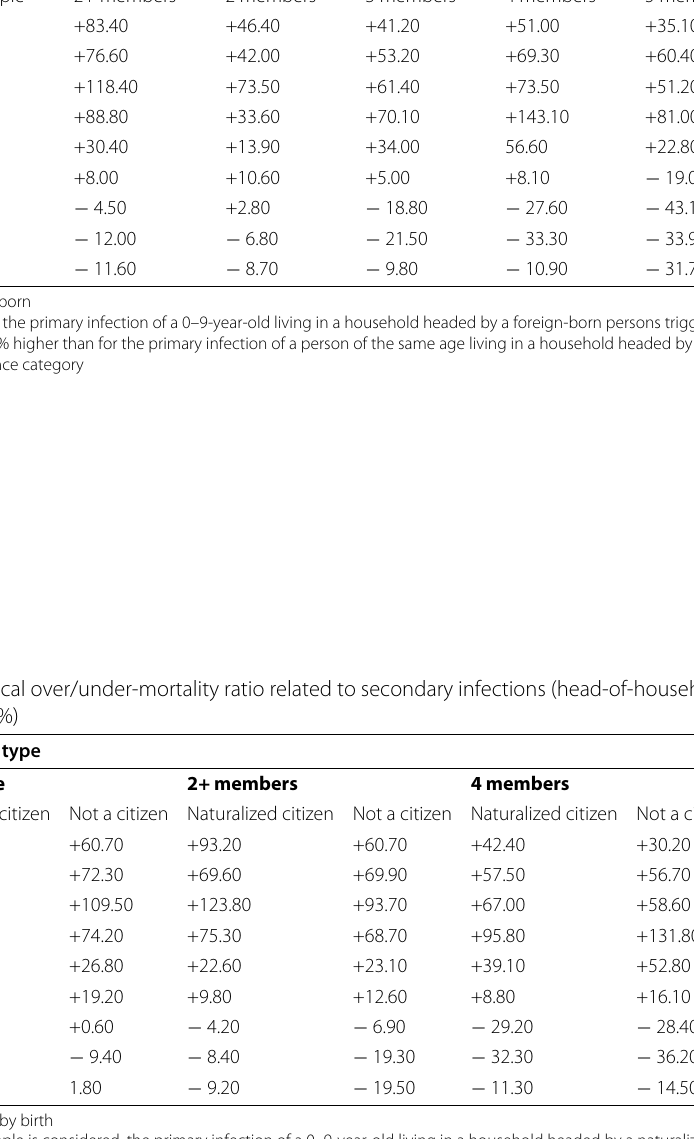
Table 13 Theoretical over/under-mortality ratio related to secondary infections (head of household nativity status-%)